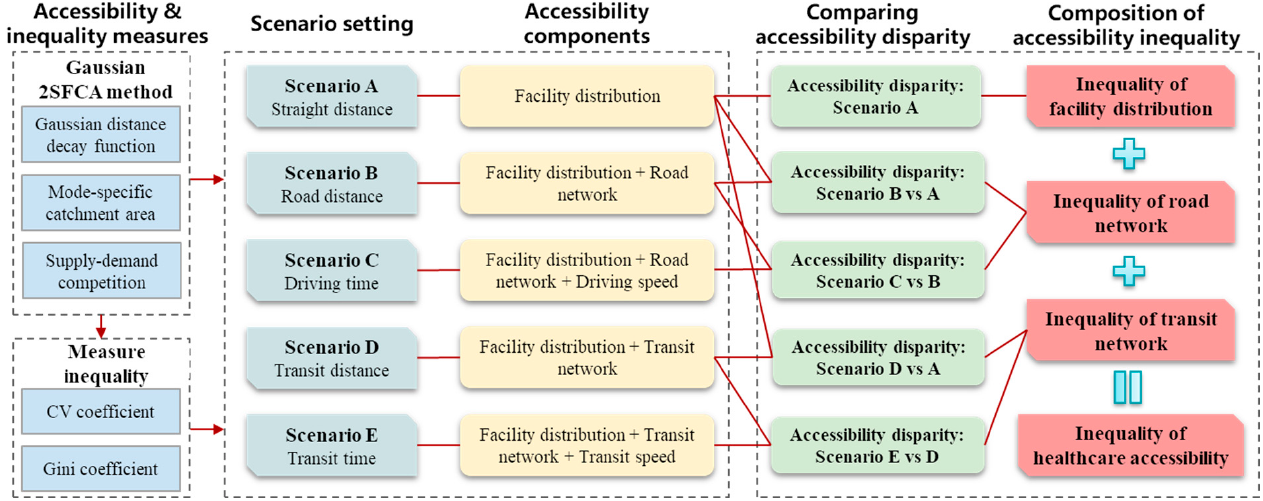
Figure 1. Research framework in this study.